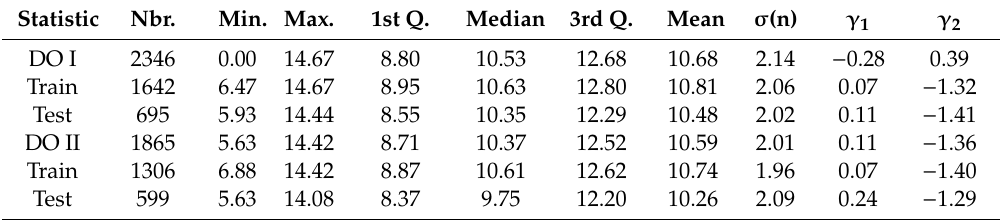
Table 1. Statistical indices of DO data, divided by Total, Train, Test s for both stations.